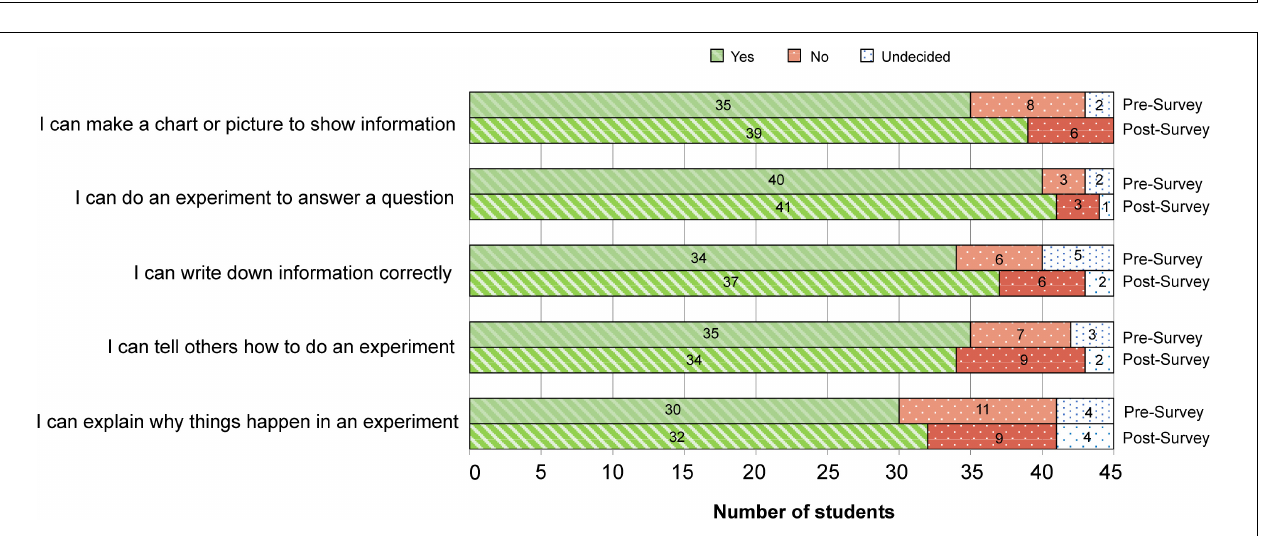
FIGURE 7 | Critical thinking statements. Results from the questions that evaluate critical thinking in science learning adapted from Perkins and Mincemoyer (2002). Demonstrates number of students that selected each answer. Pre and post survey answers are stacked directly, respectively, on top of each other for each question. Cronbach alpha 0.826 and 0.831 for pre and post survey, respectively.